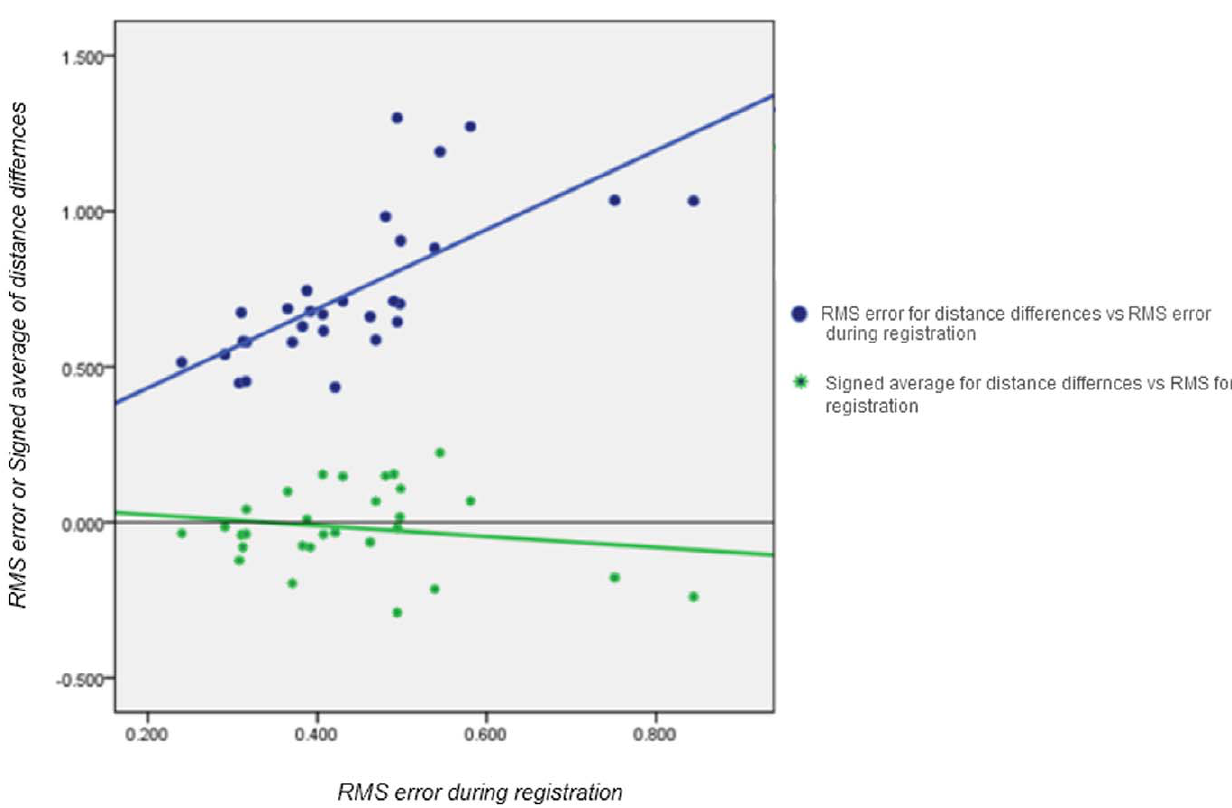
Figure 8. Scatter plot of the relationship between measurements used for error analysis.